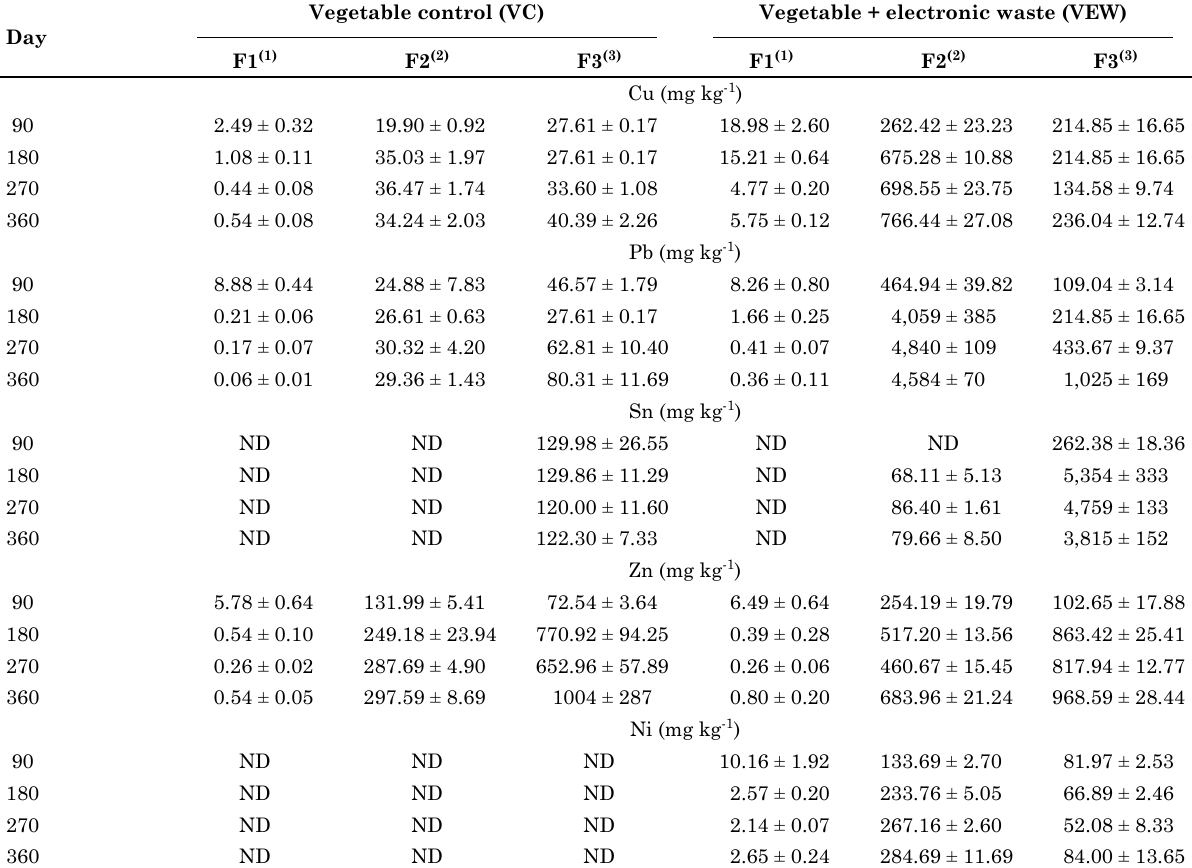
table 2. metal concentrations in the compost from vegetable residues determined by sequential extraction (f1, f2 e